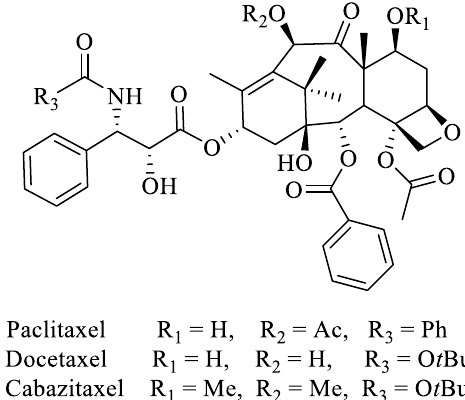
Figure 1. Structures of paclitaxel, docetaxel, and cabazitaxel.